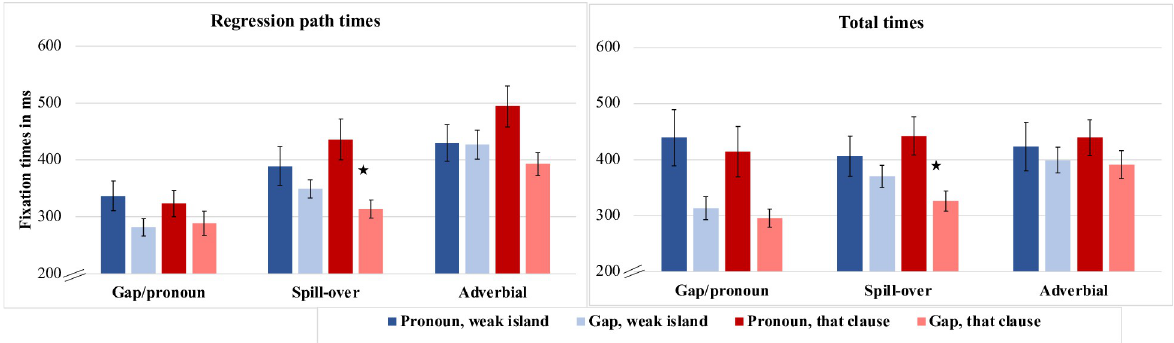
Fig 2. Regression path times and total times (ms) across regions for Experiment